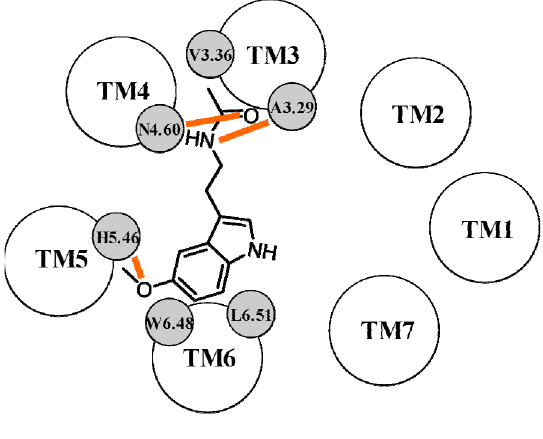
Figure 10. Representation of the binding scheme of melatonin proposed by Zefirova et al. within the MT binding site. Hydrogen bond interactions are depicted with orange 2